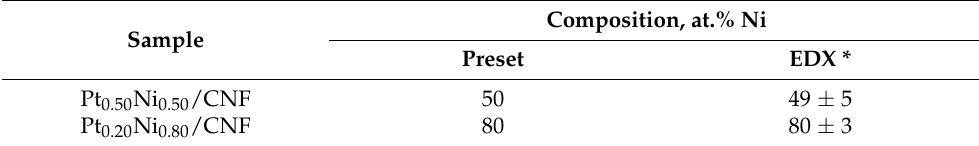
Table 3. EDX data for the Pt 1 − x Ni x /CNF samples.